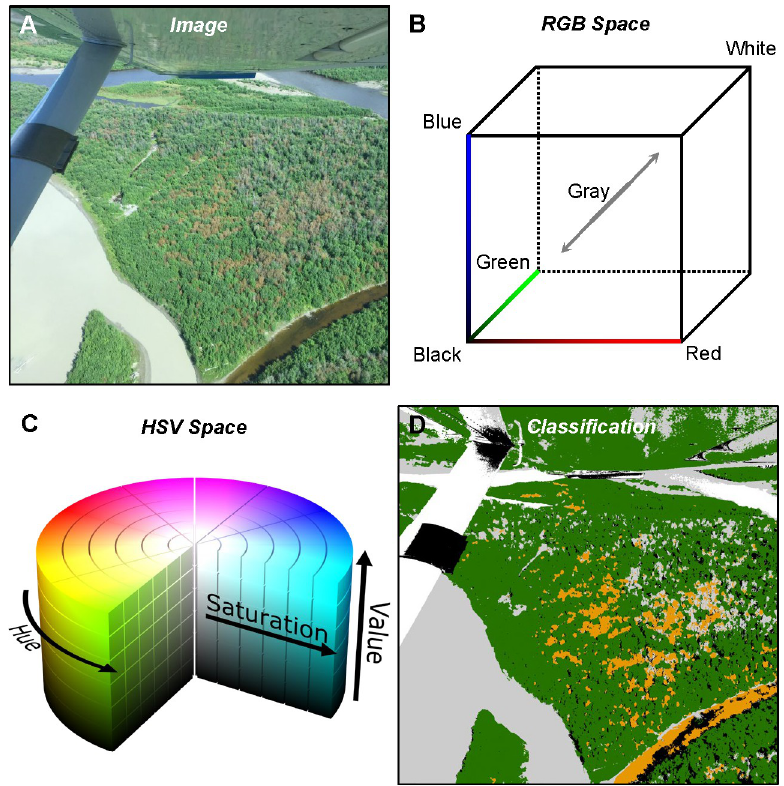
Fig 1. Conceptual model of Tree Crown Health (TCH). (A) Visible damage, as illustrated in the aerial photo on the left, is typically captured by red and gray crowns, whereas healthy crowns appear green, and crown shadows appear dark/black. (B) Photo interpreters perceive these crown color classes and collect training data in red, green, blue (RGB) color space. (C) TCH models are trained after converting RGB to hue, saturation, value (HSV) color space. (D) The classification model is projected back onto the image, where orange = red model class, light gray = gray model class, dark green = green model class, black = shadow or dark object model class, and white = background or areas unclassified by the model. Credits: Photo (A) courtesy of Alaska Division of Forestry; HSV diagram (C) from SharkD, CC BY-SA 3.0 < https://creativecommons.org/licenses/by-sa/3.0 > , via Wikimedia Commons.